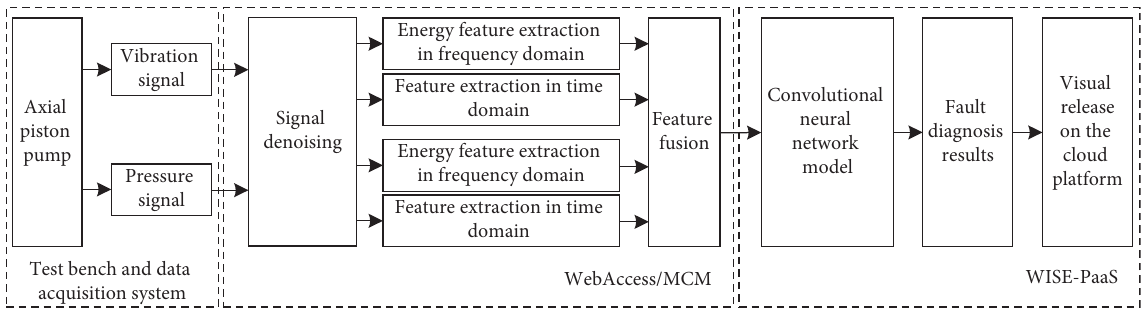
Figure 21: Cloud platform realization of the fault diagnosis method of axial piston